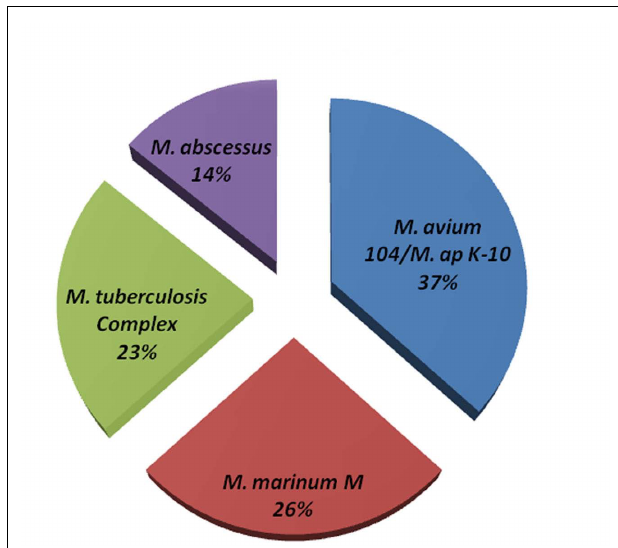
FIGURE 2 | Genome composition of M. avium Env 77. MegaBLAST algorithm was used to identify closely related bacteria to all contig sequences from the M. avium Env 77 isolate. Genomes with < 10% homology were excluded from representation. Members of the M. tuberculosis complex included M. tuberculosis and M. bovis with sequence divergence < 5%.The same criteria was used to formulate M. avium and M. ap